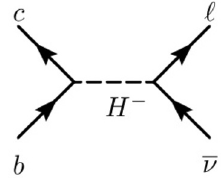
Figure 4 . Tree level contribution to b → c‘ν